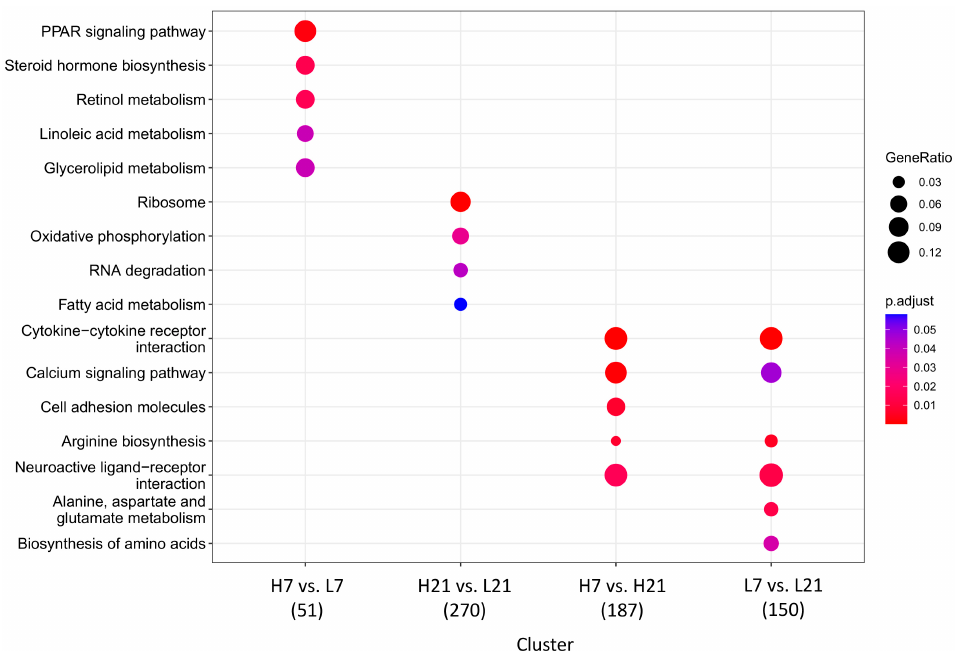
Figure 3. Identification of Gene Ontology (GO) terms of different groups. ( A ) H7 vs. L7 GO terms. ( B ) H21 vs. L21 GO terms. ( C ) H7 vs. H21 GO terms. ( D ) L7 vs. L21 GO terms. H7: High H/L SE- infected 7 dpi (n = 6); L7: Low H/L SE-infected 7 dpi (n = 7); H21: high H/L SE-infected 21 dpi (n = 5); L21: Low H/L SE-infected 21 dpi (n = 4).